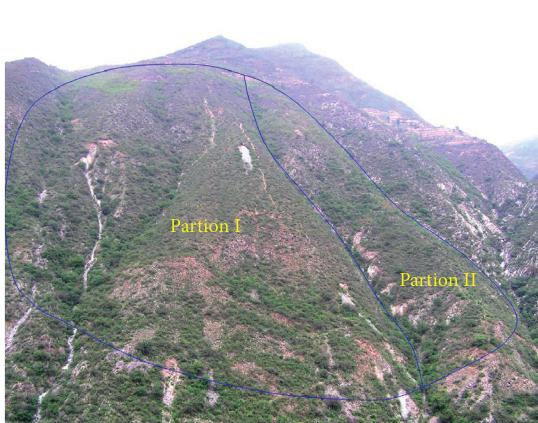
Figure 3: Partition map of the Hejia